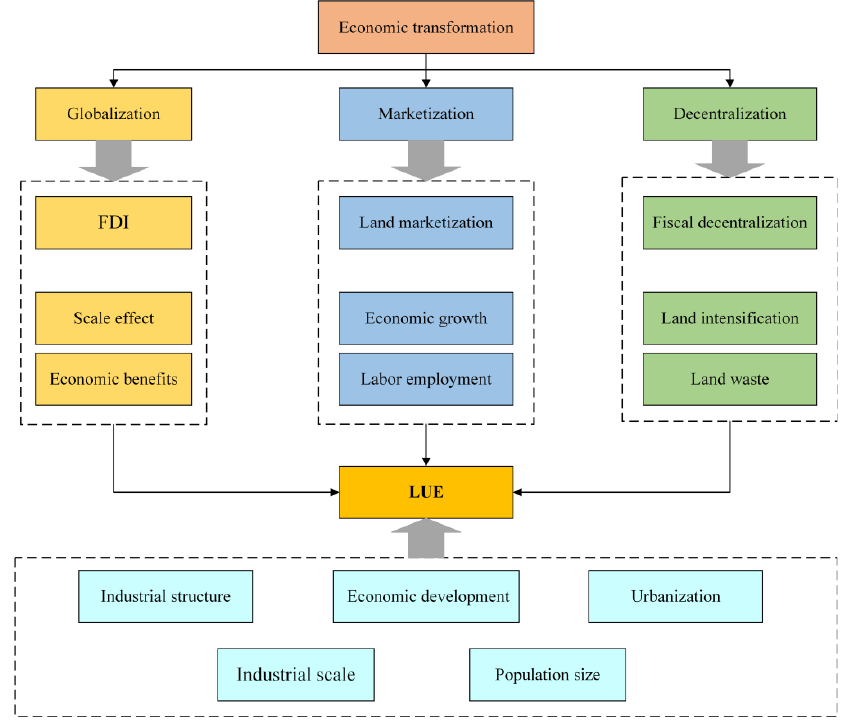
Figure 2. Theoretical analysis framework of economic transformation and LUE.